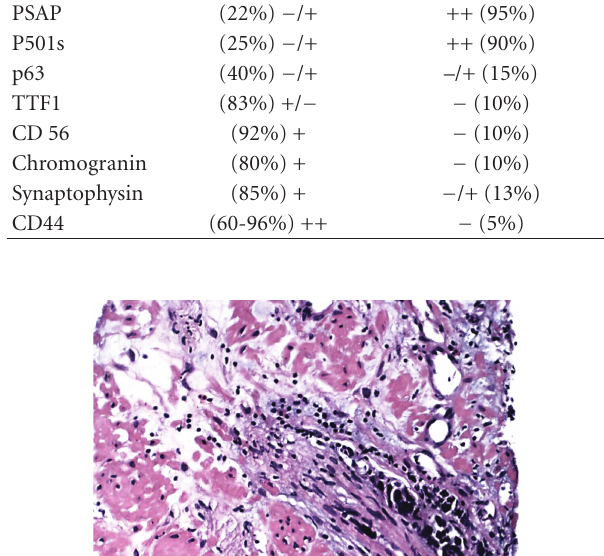
Figure 6: Small cell carcinoma with strong positivity for chromo- granin